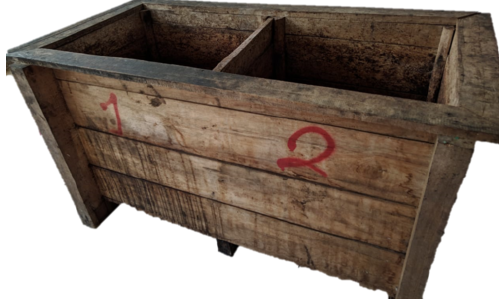
Figure 1. A wooden sweatbox (with 2 slots) used in the cocoa fermentation